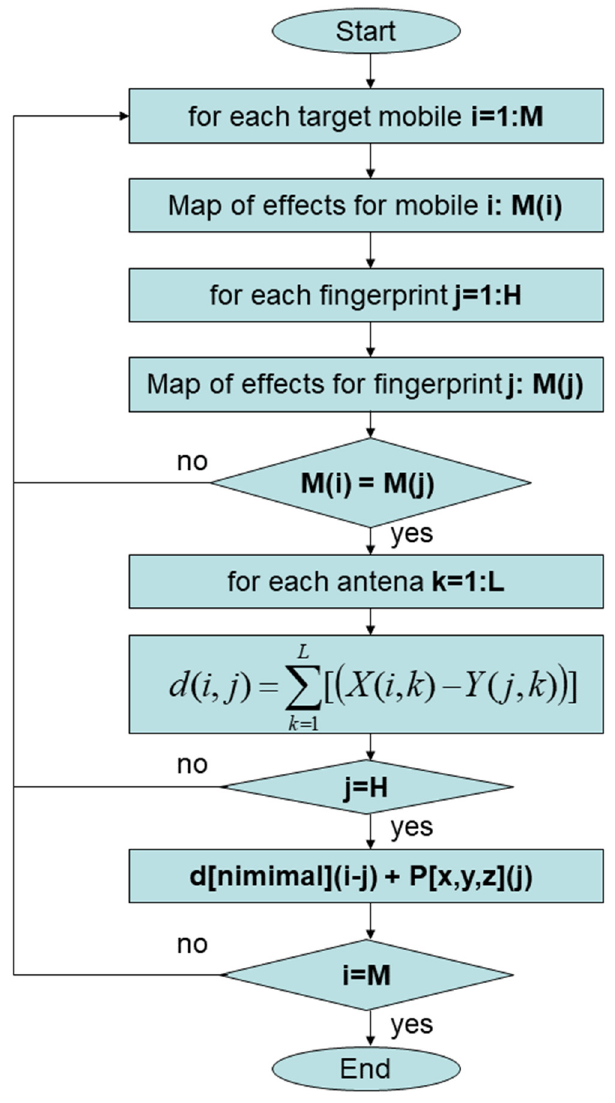
Figure 4. Pseudo-code of the localization algorithm.